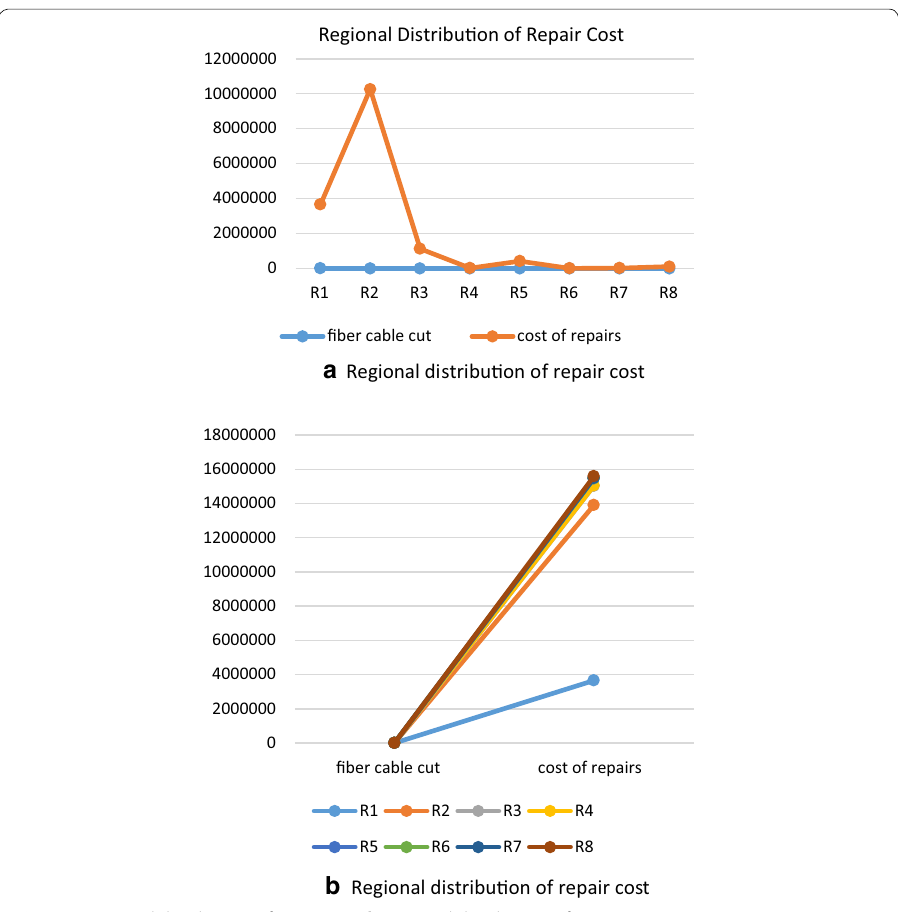
Fig. 2 a Regional distribution of repair cost. b Regional distribution of repair cost